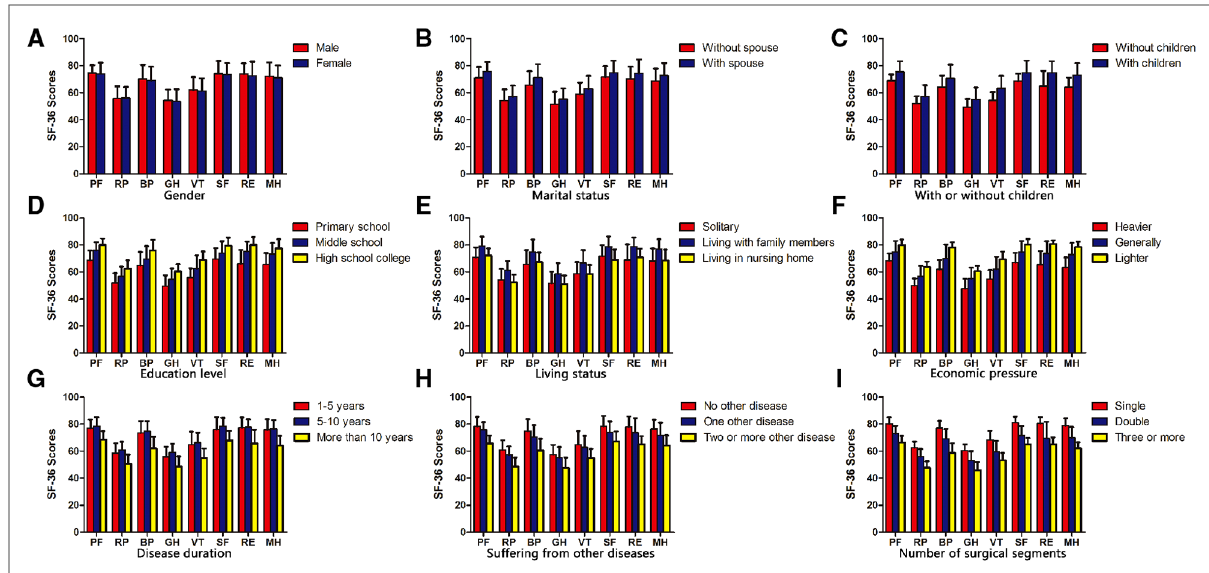
FIGURE 4 Comparison of quality of life scores after lumbar fusion in different demographic characteristics. Comparison of quality of life scores after lumbar fusion in different situations, such as gender ( A ), marital status ( B ), with or without children ( C ), education level ( D ), living status ( E ), economic pressure ( F ), disease duration ( G ), suffering from other diseases ( H ) and the number of surgical segments ( I ).